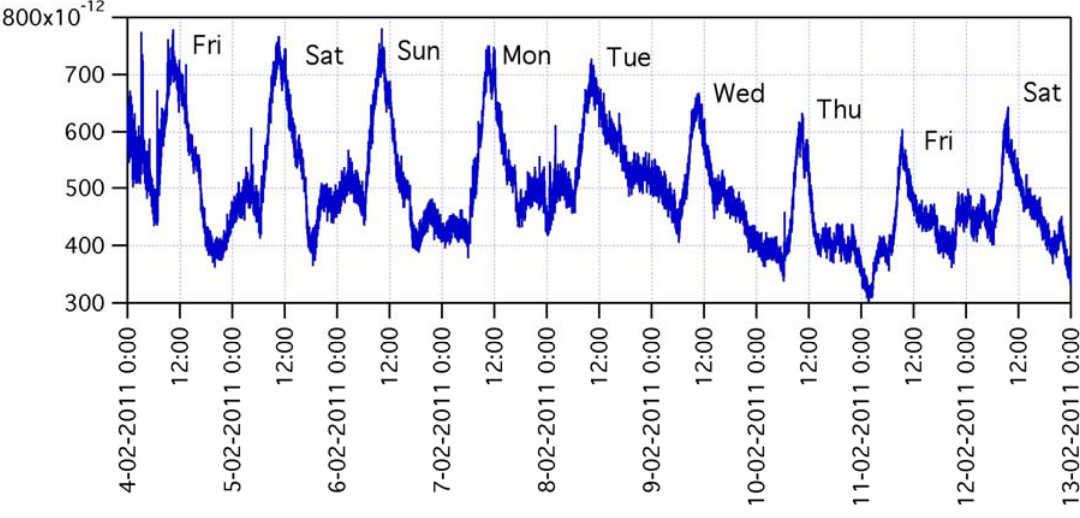
Figure 11. Zoom-in of the period between 04-02-2011 to 13-02-2011, showing day-night signal